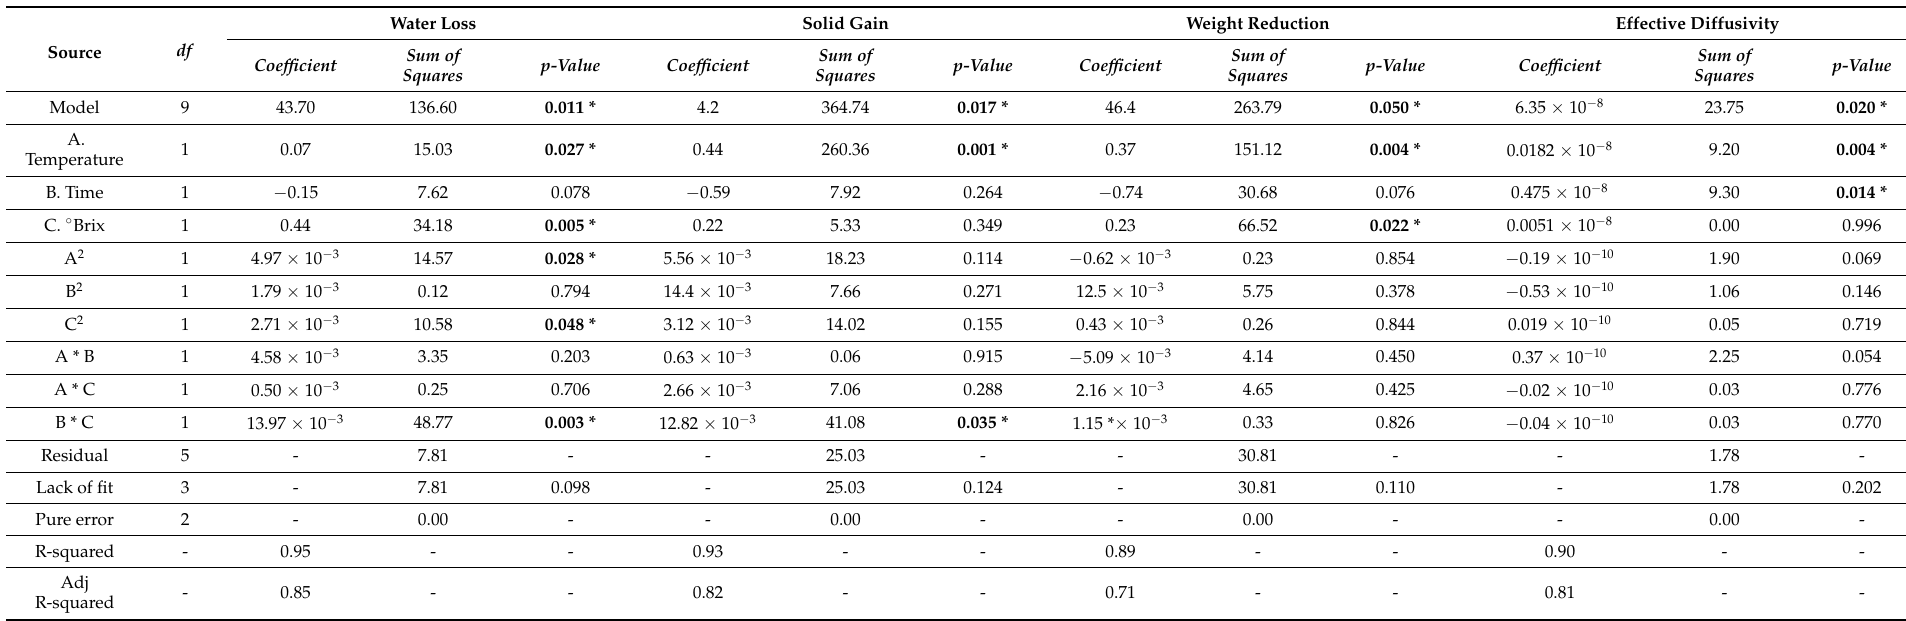
Table 3. Analysis of variance and regression analysis for OD in the erythritol osmotic solution: weight reduction, solid gain, water loss, and effective